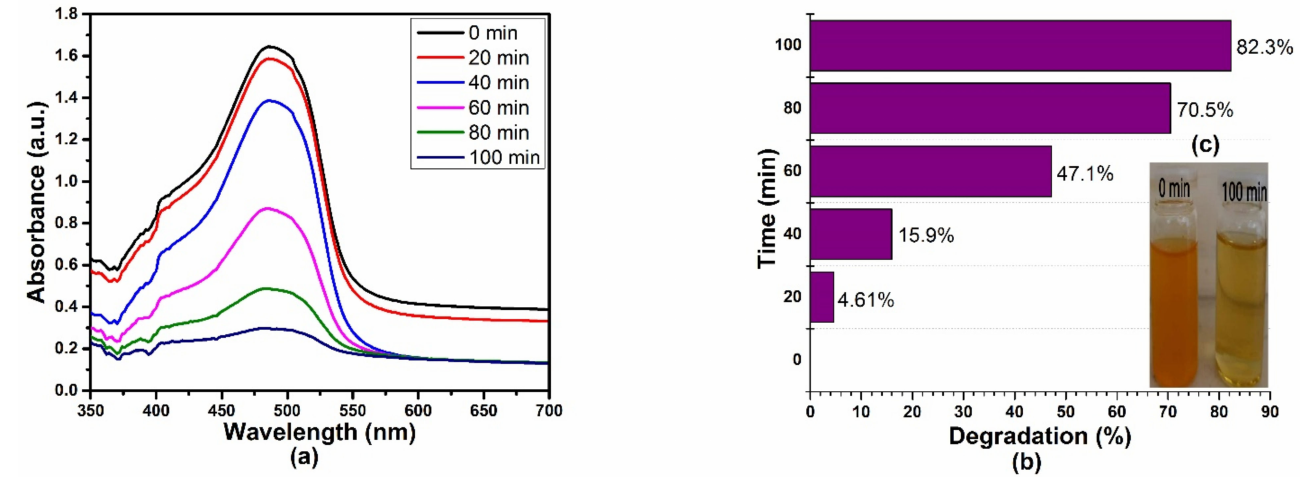
Figure 14. ( a ) Absorbance spectra of an aqueous solution of MO dye treated with (run 4) optimized AgNPs at 100 min of irradiation, ( b )% of dye degradation at different time intervals, ( c ) image of 0 min and 100 min degradation of